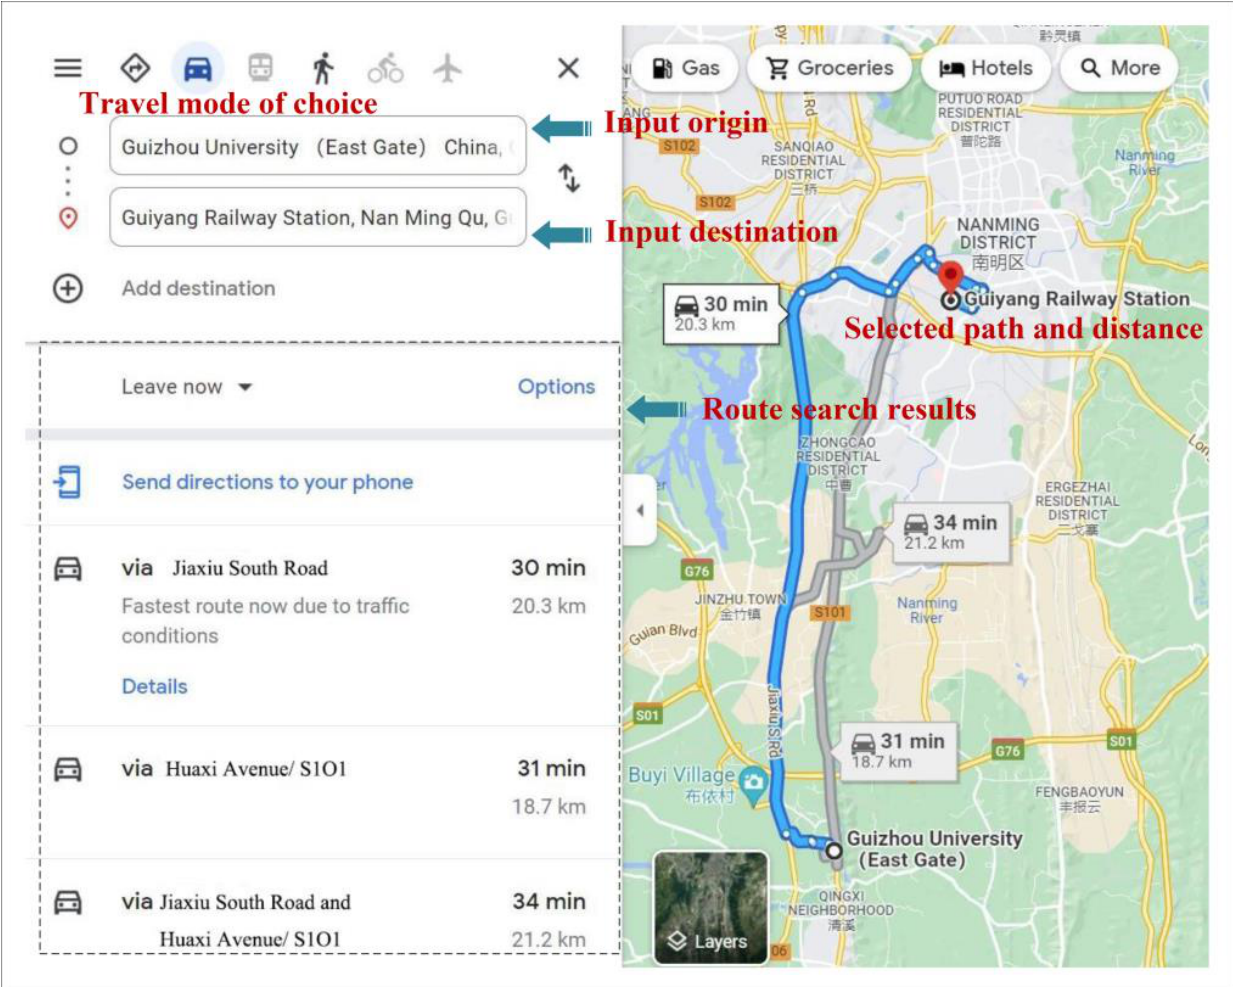
Figure 2. Display of the path search of online map.